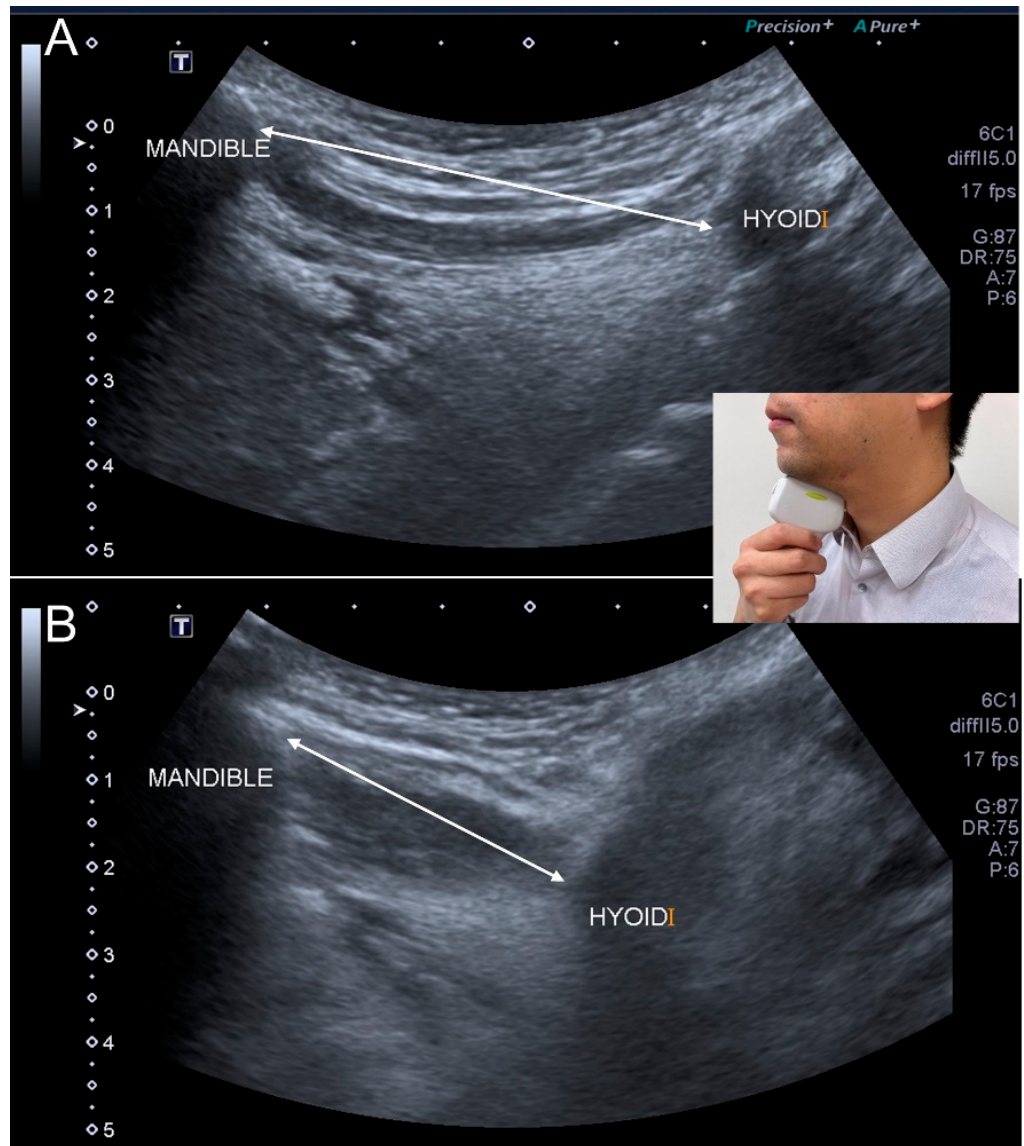
Figure 8. Ultrasonographic images show the hyoid movement at the onset of swallowing ( A ) and the moment of maximal displacement ( B ). Double-headed line, the distance between the mandible and hyoid bone.